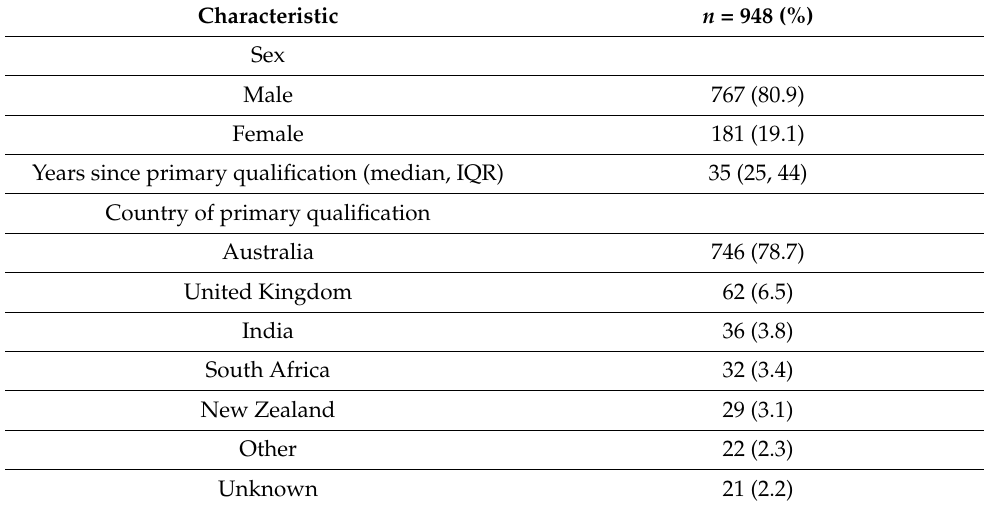
Table 1. Demographic